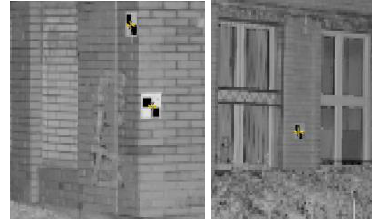
Figure 3. Checkerboard as a targets used in the experiment Scanning was conducted in a 41 stations with 160 targets with known coordinates of global coordinate system. The accuracy of the reference points were approx. 5 cm and scan resolution 1- 2 cm. Not all of the targets were used as the reference points in registration. Some of them were outliers (eliminated in the pre- processing), some of them were used as check